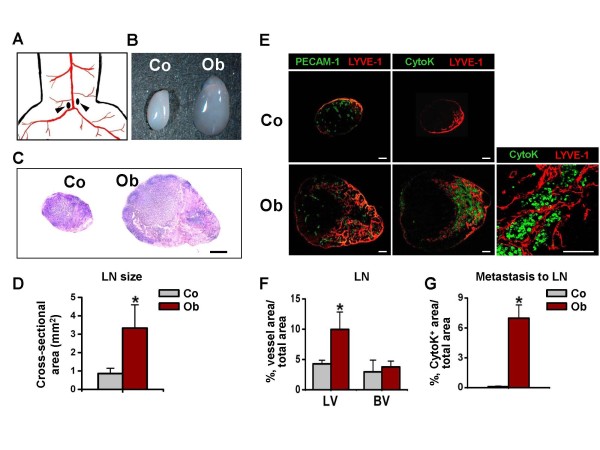
OUBC displays profound increases in sizes of SLN and metastatic spread of cancer cells to SLN. PBS (Control, Co) or 1 × 106 MBT-2 cells (OUBC, Ob) were injected into the urinary bladders of 8-10-week old female C3H mice. 4 weeks after PBS or tumor cell injection, medial iliac lymph nodes (LN) (arrows, A) were harvested as SLN, and photographed (B), and H&E stained (C, scale bars, 100 μm). (D) Comparison of cross-sectional areas of LNs. Graph shows mean ± SD; n = 5 for each group. *p < 0.05 versus Co. (E) Images showing LYVE-1+ LVs, PECAM-1+ BVs, and cytokeratin+ (CytoK+) metastatic cancer cells in LNs. Right panel; high magnification view showing that the CytoK+ metastatic cancer cells congregate closely to the lymph node lymphatic vessels of OUBC. Scale bars, 50 μm. (F) Comparison of LVD and BVD per total sectioned area of LNs. Graph shows mean ± SD; n = 5 for each group. *p < 0.05 versus Co. (G) Comparison of densities of CytoK+ metastatic cancer cells in LNs. Graph shows mean ± SD; n = 5 for each group. *p < 0.05 versus Co.